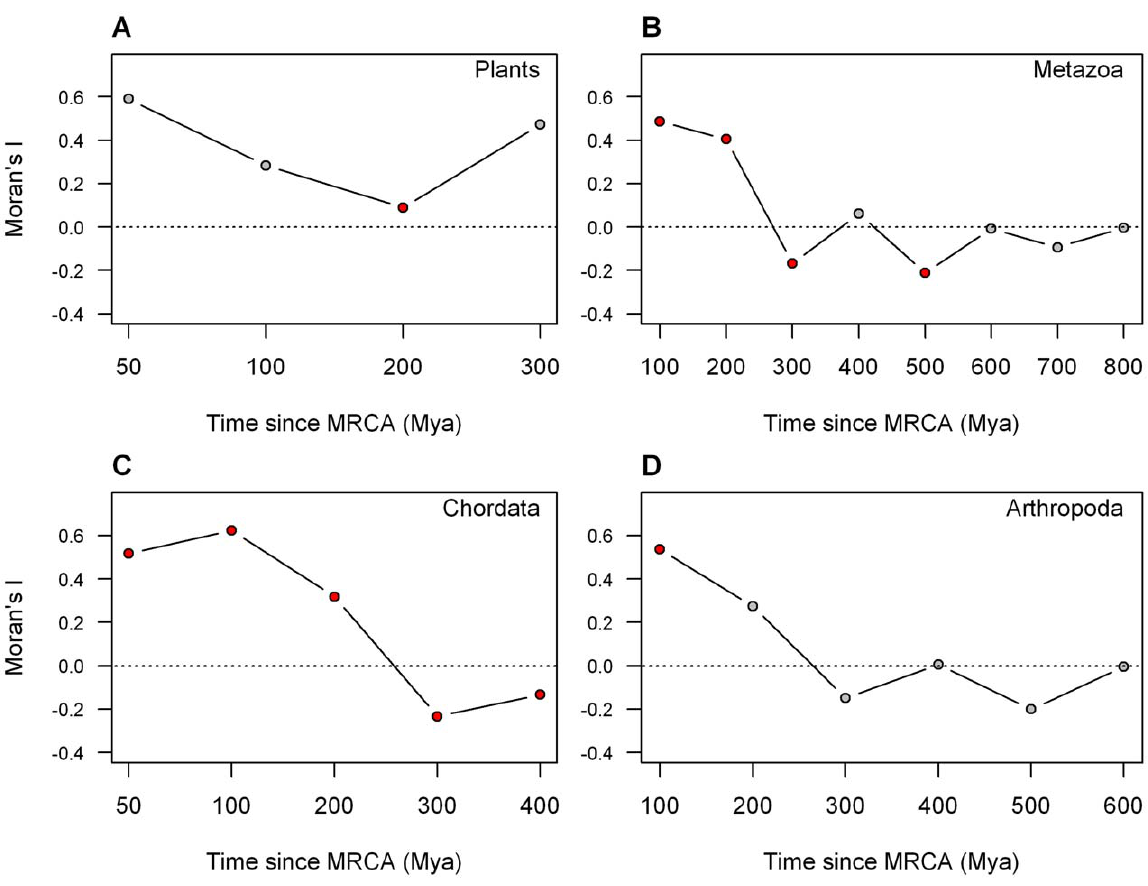
Figure 3. Autocorrelation analyses of total microsatellite coverage . (A) Plants, (B) Animals, (C) Chordates, (D) Arthropods. Red symbols: P , 0.05, grey symbols: P $ 0.05.